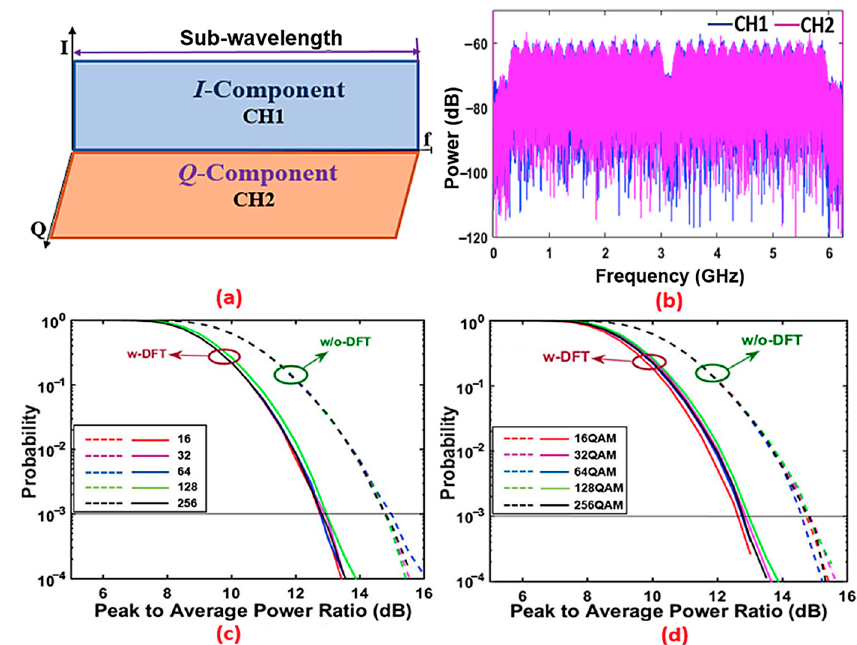
Figure 2. ( a ) Spectral location of orthogonally digitally filtered sub-band signals (I-phase and Q- phase) and ( b ) their spectra. CCDFs of PAPR for ( c ) varying digital filter lengths and a fixed 64-QAM modulation format, and ( d ) varying modulation formats and a fixed digital filter length of 64.